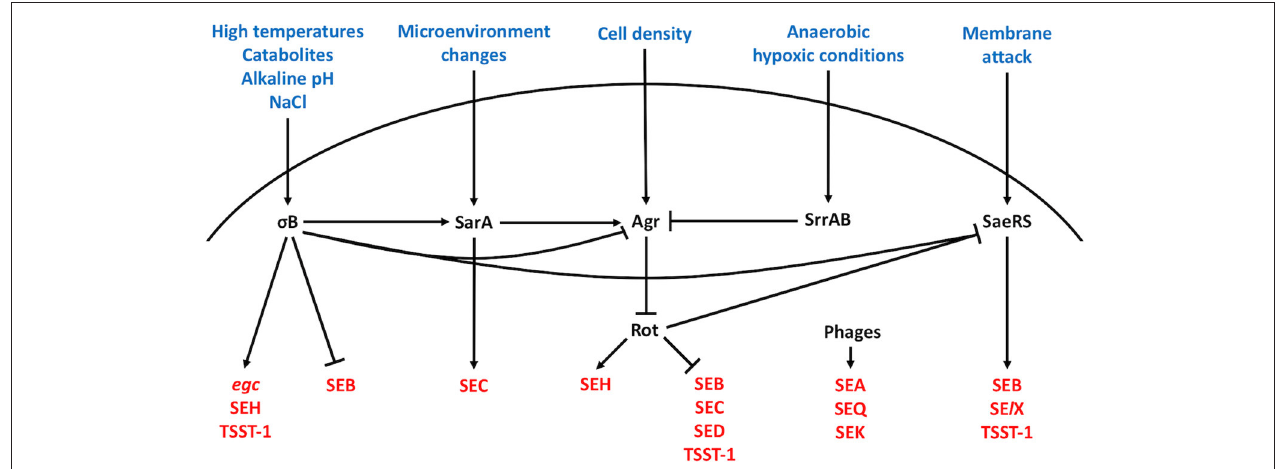
FIGURE 1 | Regulation of staphylococcal enterotoxins. Harsh bacterial growth conditions, changes in the bacterial microenvironment, high cell density, hypoxia, and membrane changes direct enterotoxin expression through the alternative sigma factor, SarA protein family, Agr quorum sensing system, SrrAB protein, and SaeRS two-component system, respectively. The excitatory and inhibitory action of these systems on the other regulators and enterotoxins are summarized. Arrowheads represent upregulation and bars downregulation.